Question: Write a descriptive caption for this figure.
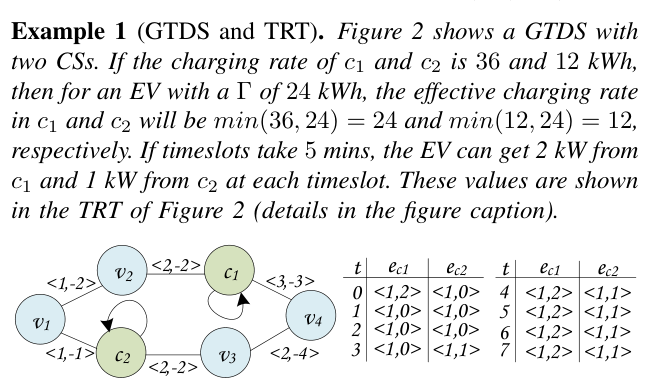
Answer: Example of a GTDS where each vi represents vertices, c1 and c2 represent two CSs. The weight w(e) and resource unit u(e) of each edge is shown as a pair of < w, u > values with each edge. The shown table is the TRT, with a column for each self-loop for 8 timeslots. Each pair < 1, u > means that, by spending a timeslot, EV can gain u unit of charge. If a timeslot is reserved at a CS, u is zero for that entry (e.g., the first 3 timeslots in c2).